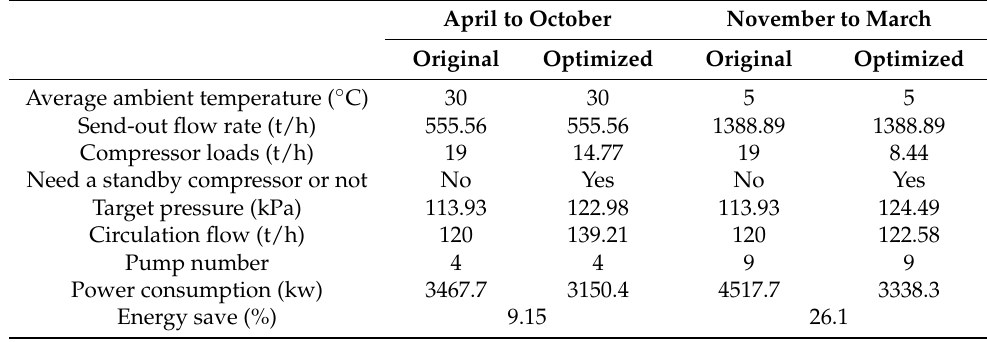
Table 11. Comparisons of data of the operating variables and